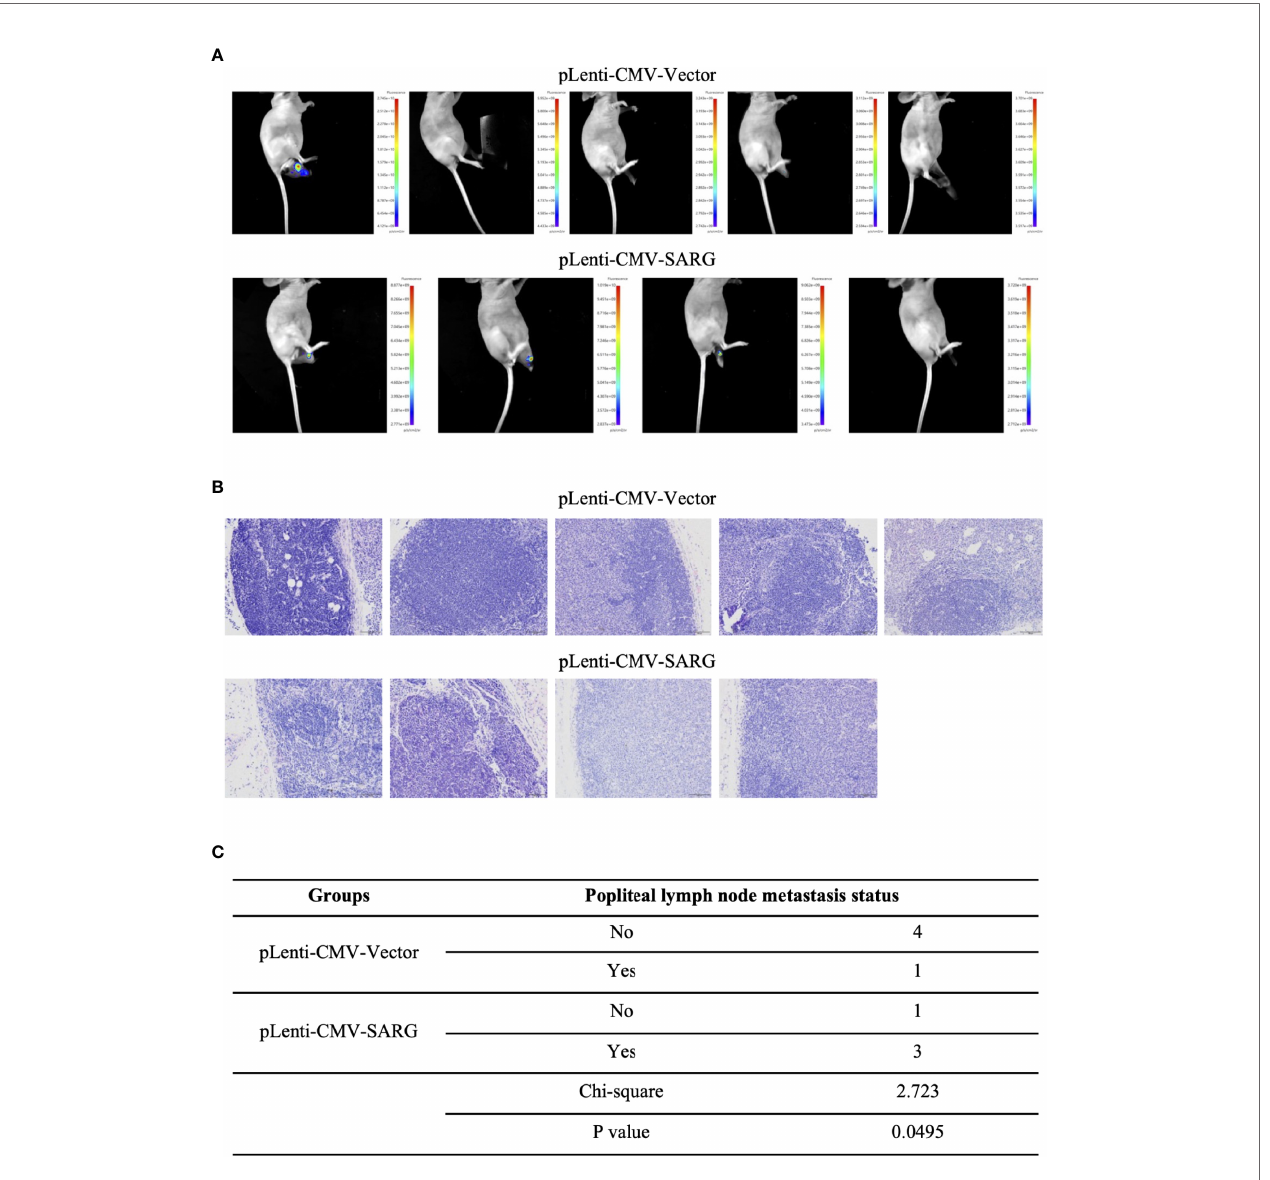
FIGURE 5 | SARG overexpression promoted popliteal lymph node metastasis of PTC cells footpad xenografts in mice. (A) TPC-1 cells overexpressed SARG were injected subcutaneously into the footpads of nude mice, 5 weeks later, lymphatic spread was detected by bioluminescence imaging. (B) Hematoxylin and eosin staining of popliteal lymph node at the termination. Scale bars, 100 µm. (C) c 2 test of the popliteal lymph node metastasis